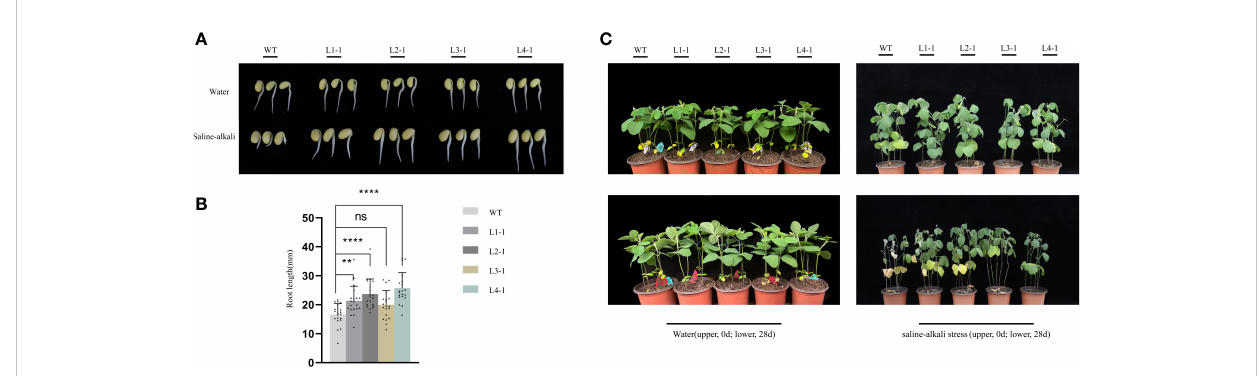
FIGURE 2 AhALDH3H1 over-expression increased saline-alkali tolerance of transgenic soybean. (A) Germination analysis of AhALDH3H1 transgenic seeds under saline-alkali stress. Seeds germinated with pH 8.9 saline-alkali solution treatment. WT, wild type. L1-1, L2-1, L3-1, and L4-1, transgenic lines. (B) Root length collection of germinated WT and transgenic lines under saline-alkali treatment. (C) Morphological changes between transgenic plants and their receptor under water (upper line) and saline-alkali stress (lower line). Statistical analysis was performed using t -test ( P < 0.05), * P < 0.05, ** P < 0.01, *** P < 0.001, and **** P < 0.0001. ns, no statistical signi fi cance.